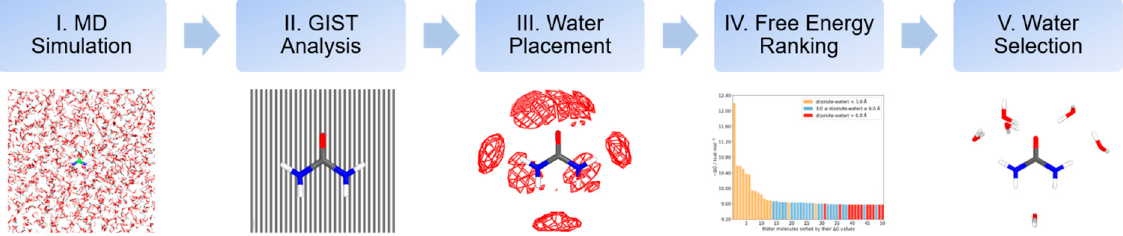
Figure 1. Workflow for the automated generation of microsolvated structures retrieved with our Free Energy Based Identification of Solvation Sites (FEBISS) algorithm from molecular dynamics (MD) data and grid inhomogeneous solvation theory (GIST) analysis.